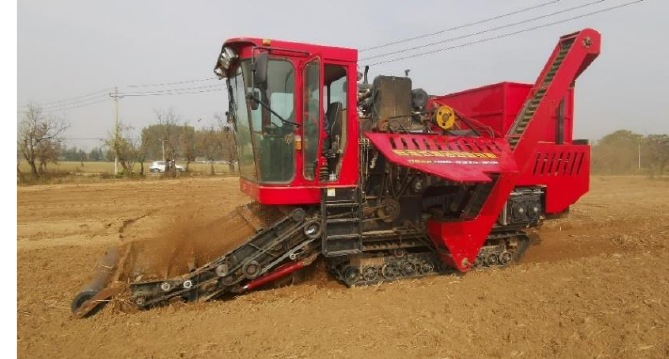
Figure 19. Field tests of the harvester.